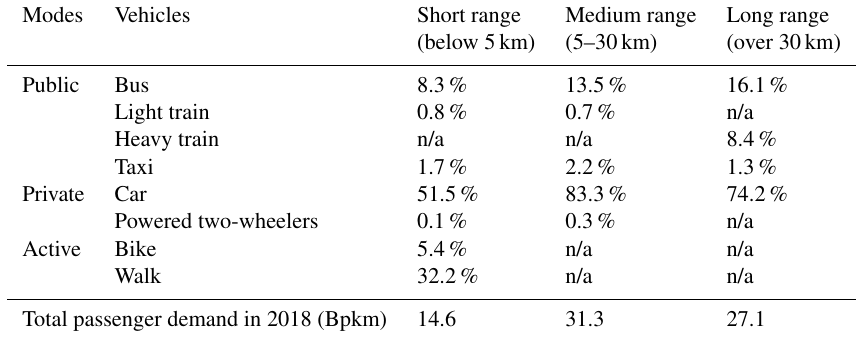
Table 4. Total passenger demand and share of transport modes for each class of distance range (CSO, 2017, 2020c, e, f, g, h). Modes